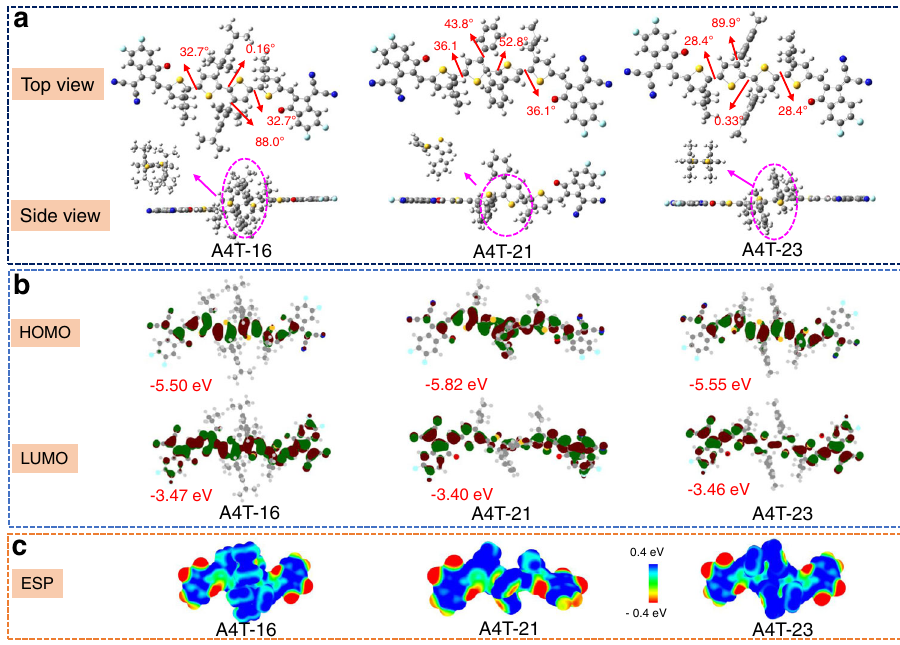
Fig. 2 DFT calculation results of A4T-16, A4T-21, and A4T-23. a The optimal geometries. b DFT-calculated frontier molecular orbitals. c ESP distributions for the simpli fi ed structures of A4T-16, A4T-21, A4T-23 at the B3LYP/6-31 G(d,p)